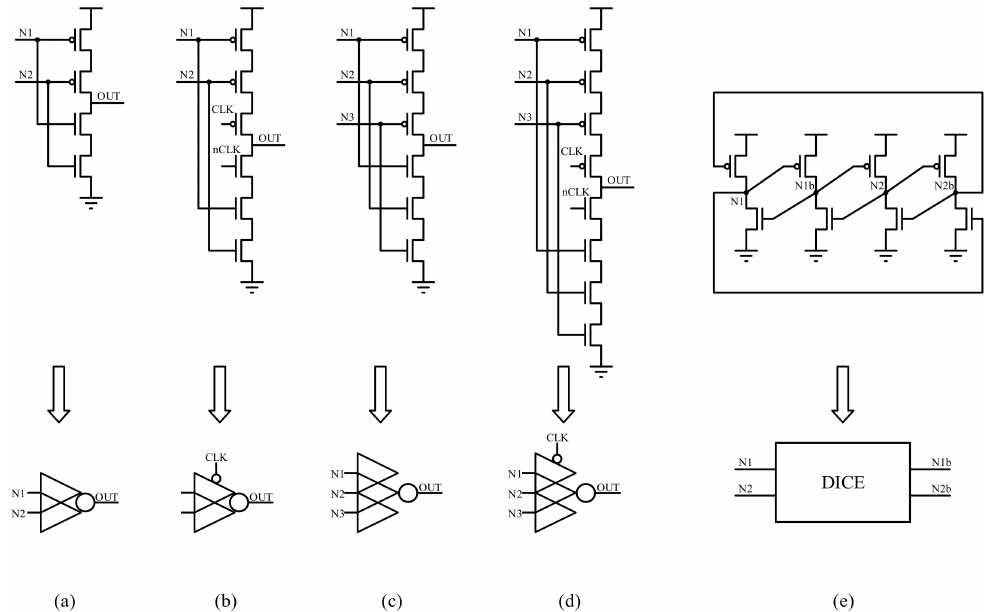
Figure 1. C-elements and DICE: ( a ) 2-input C-element; ( b ) CG-based 2-input C-element; ( c ) 3-input C-element; ( d ) CG-based 3-input C-element; ( e )